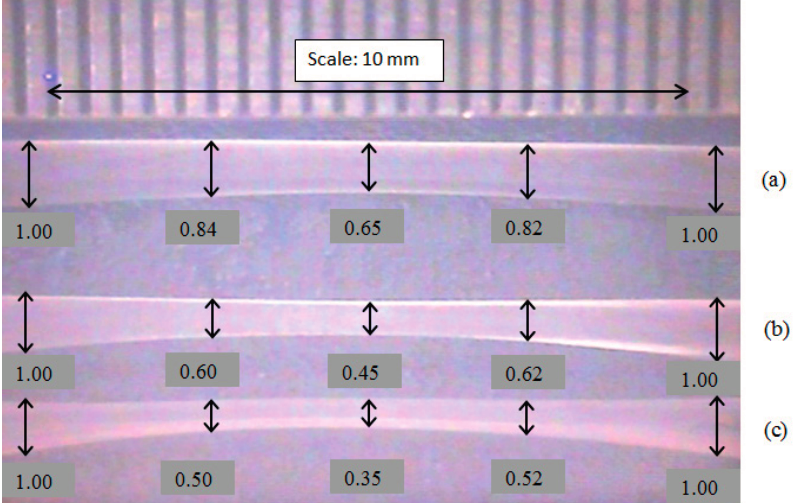
Figure 1. Three tapered POF based sensors with waist diameter ( a ) 0.65 mm ( b ) 0.45 mm and ( c ) 0.35 mm. All of the measurements done in these three tapered POF are in the unit of